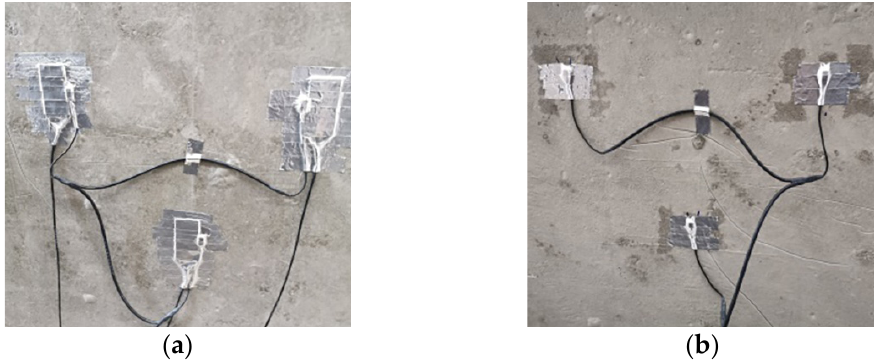
Figure 5. Thermal performance tests: ( a ) S-50/80XPS; ( b ) B-490. The thermocouples and heat flow meters were set on both sides of the wall panel to obtain the inner, outer surface temperature, and heat flux values. As shown in Figures 6 and 7, three measuring points were arranged at different positions on the inner and outer sides. In Figure 7, the heat flow meters and thermocouples are represented by rectangles and circles, respectively. The data were automatically collected by the data acquisition instrument once every minute in the test. Because of the long-term storage of grain, only the part of heat transfer in steady-state at the later stage of the test was studied in this paper.